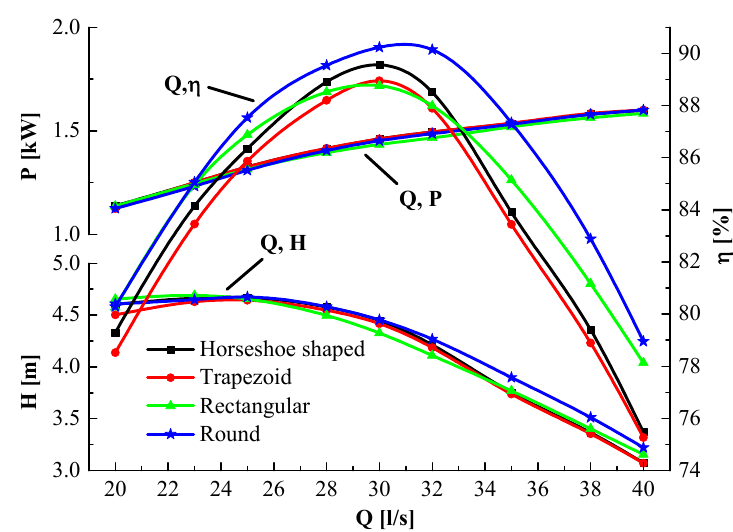
Figure 11. Performance curves of pump with different volutes.